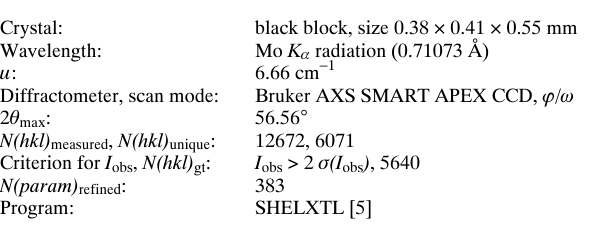
Table 7. D a t a collection a nd h a ndling.